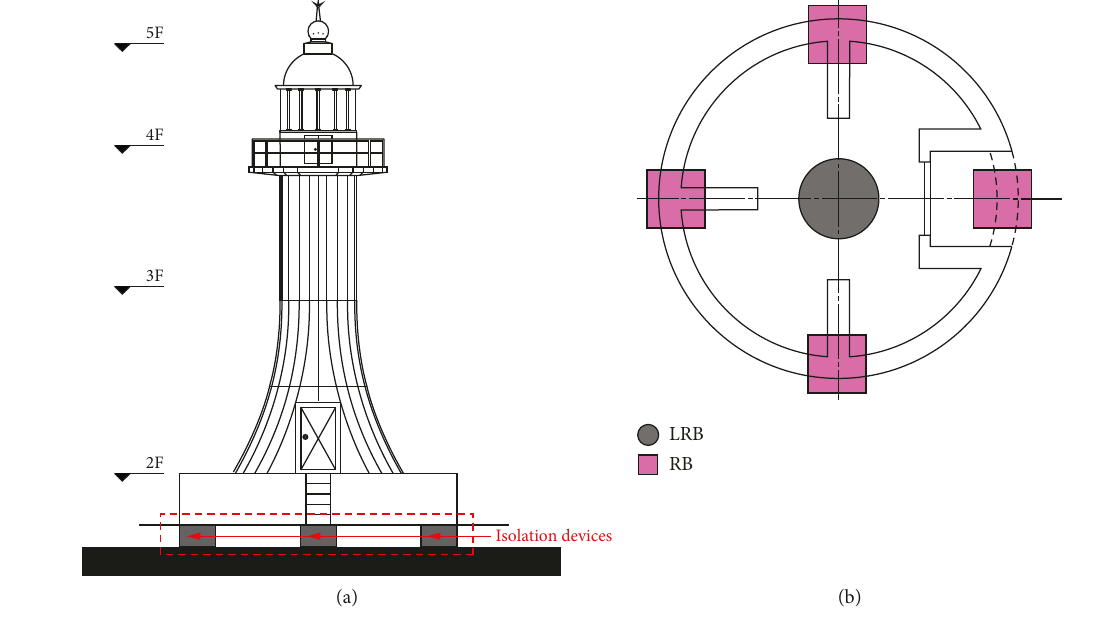
Figure 7: Section of isolation plan (Case 1). (a) Elevation (b) Plan. Table 4: Displacement of the isolation layer under the wind loads.